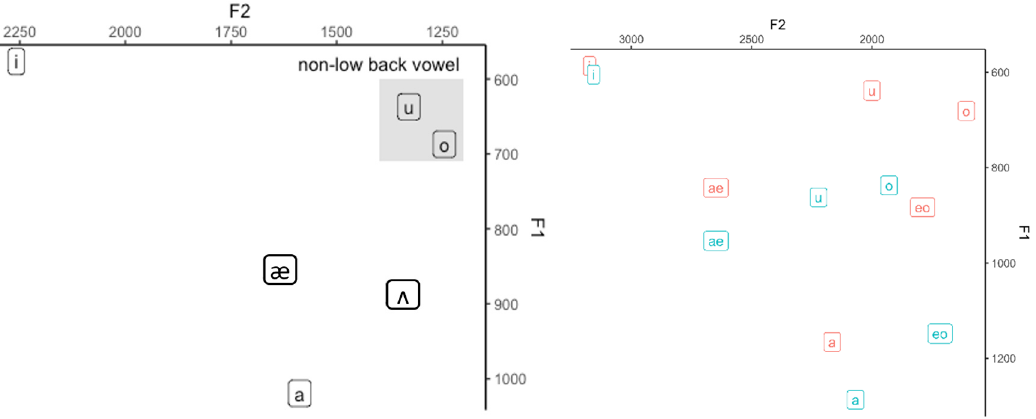
Figure 3. Vowel space for mean formants ( left ) and for mean formants of each gender ( right ). The blue vowels were produced by the girls and the red ones by the boys. [eo] in the right figure refers to [ ʌ ] in IPA. [ 2 ] in